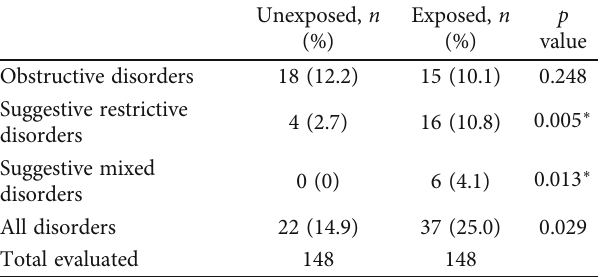
Table 4: Lung function disorders among e-waste workers in the recycling sector (exposed, n = 148 ) compared to matched unexposed subjects ( n = 148 ) in Cotonou, Benin ( N = 296